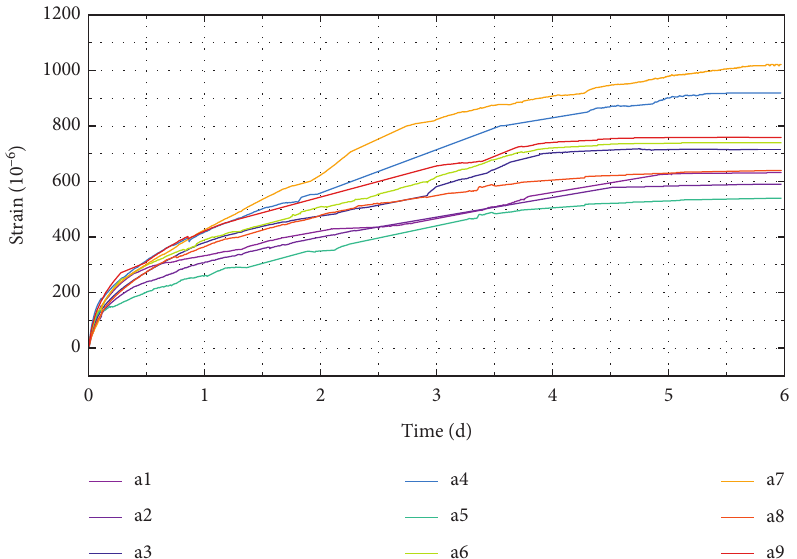
Figure 9: − 1960m core sample anelastic recovery deformation